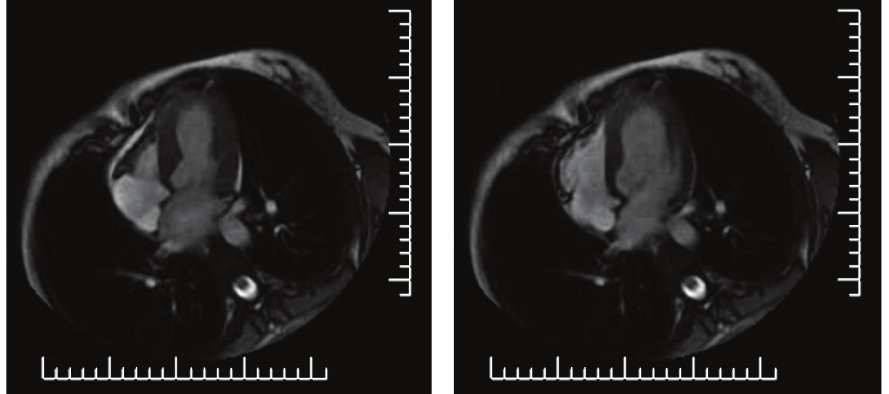
Figure 4: Contrast-enhanced CMR imaging performed 1 month after discharge shows normal ejection fraction and contractility, as well as viable, nonfibrotic